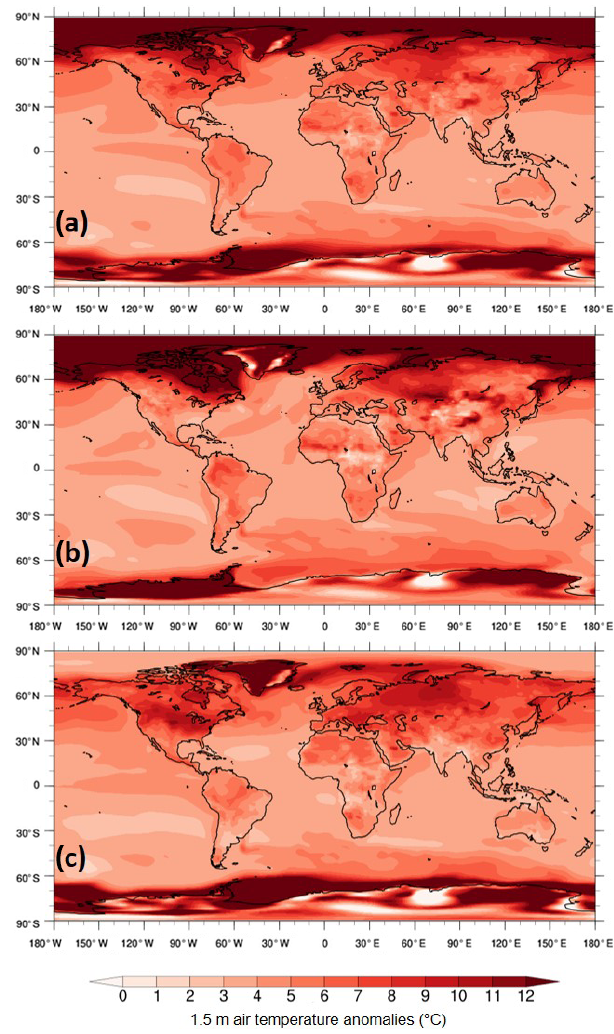
Figure 7. The 1.5m air temperature climatology differences ( mPWP − piControl_mod ) from HadGEM3: (a) annual, (b) DJF and (c)